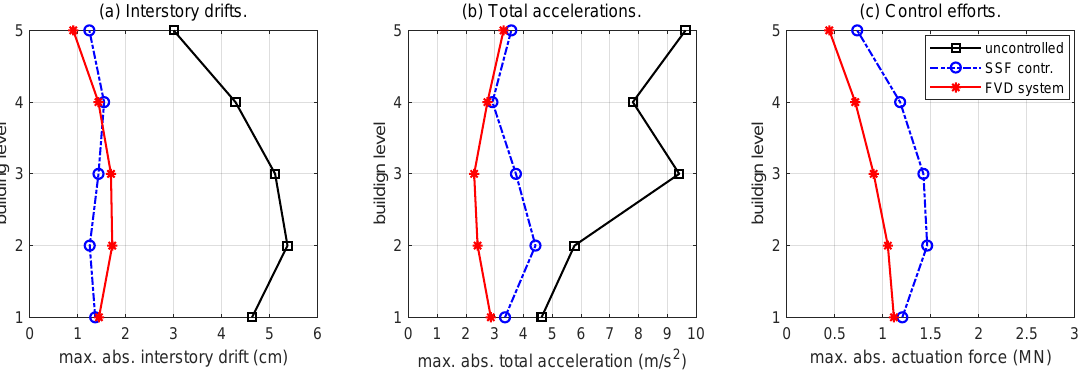
10 − 2 m). ( b ) Maximum × 10 6 N). ×